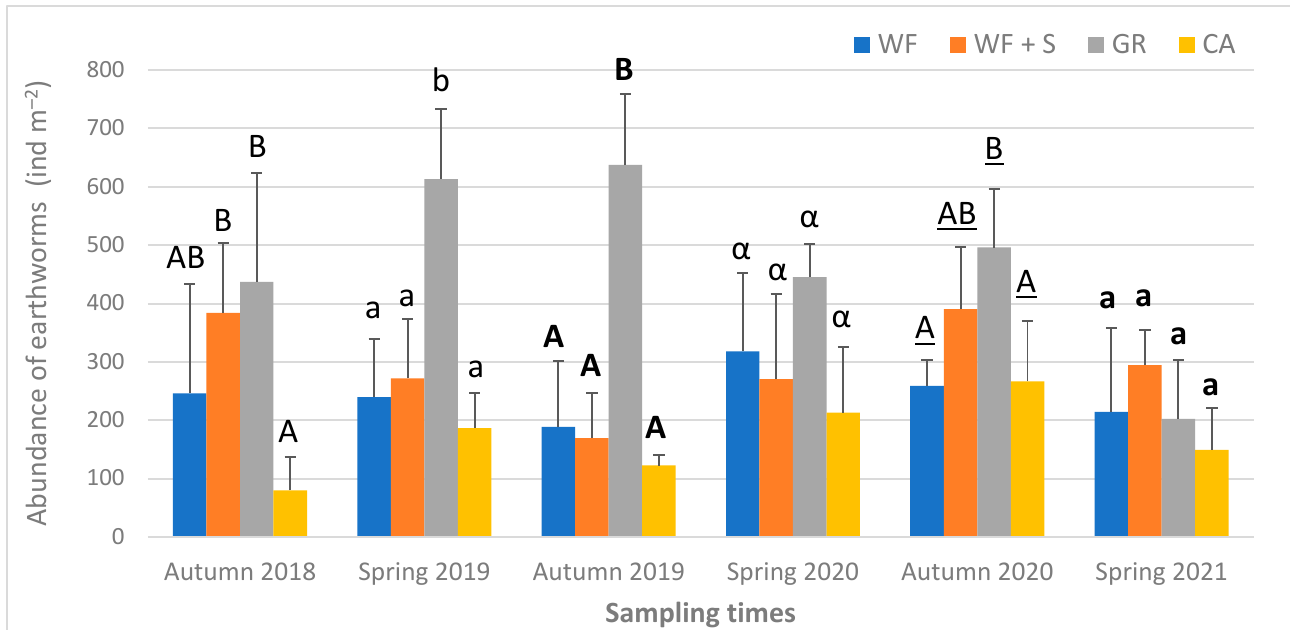
Figure 8. Abundance of earthworms between autumn of 2018 and spring of 2021. Same letters above bars mean no statistical difference. Results of each sampling times were analyzed separately from each other, so each set of results per sampling time was marked with a different type of letter. (WF: weed control fabric; WF + S: weed control fabric and straw; GR: grass vegetation; CA: cultivated alfalfa; ˝Osag á rd, Hungary).